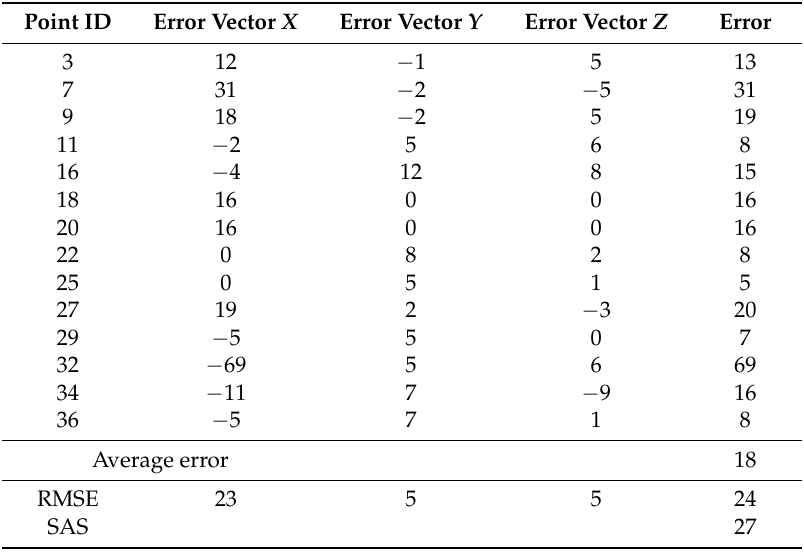
Table 3. Accuracy assessment result for 3D Photomodeling data measured from 3 m to measured object (unit: mm).